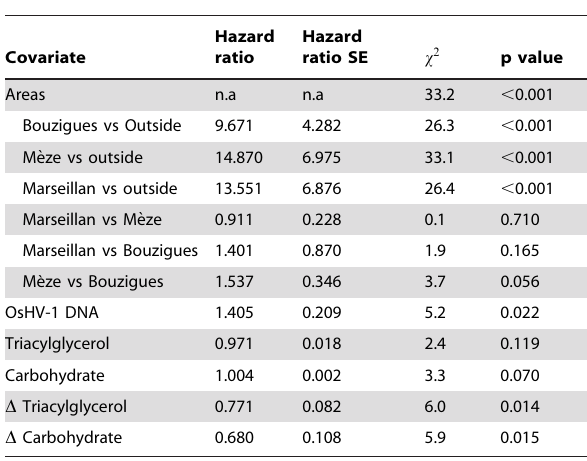
Table 2. Analysis of the effect of covariates on survival of oysters in the Thau lagoon by a Cox proportional hazards